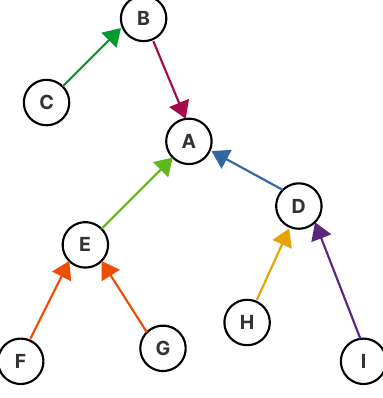
Figure 1. The Routing Protocol for Low-Power and Lossy Networks (RPL) constructs a tree-like routing topology, called the Destination-Oriented Directed Acyclic Graph (DODAG), rooted at one or more border router. Each node has a rank that defines the routing distance from said node to its